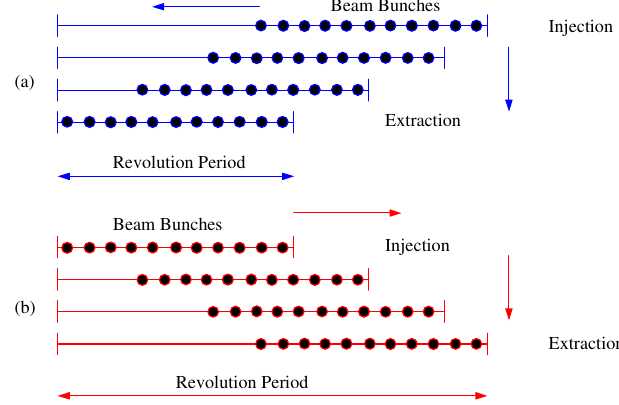
FIG. 3. (Color) Bunch to bucket configuration below transition energy (a) and above transition energy (b).